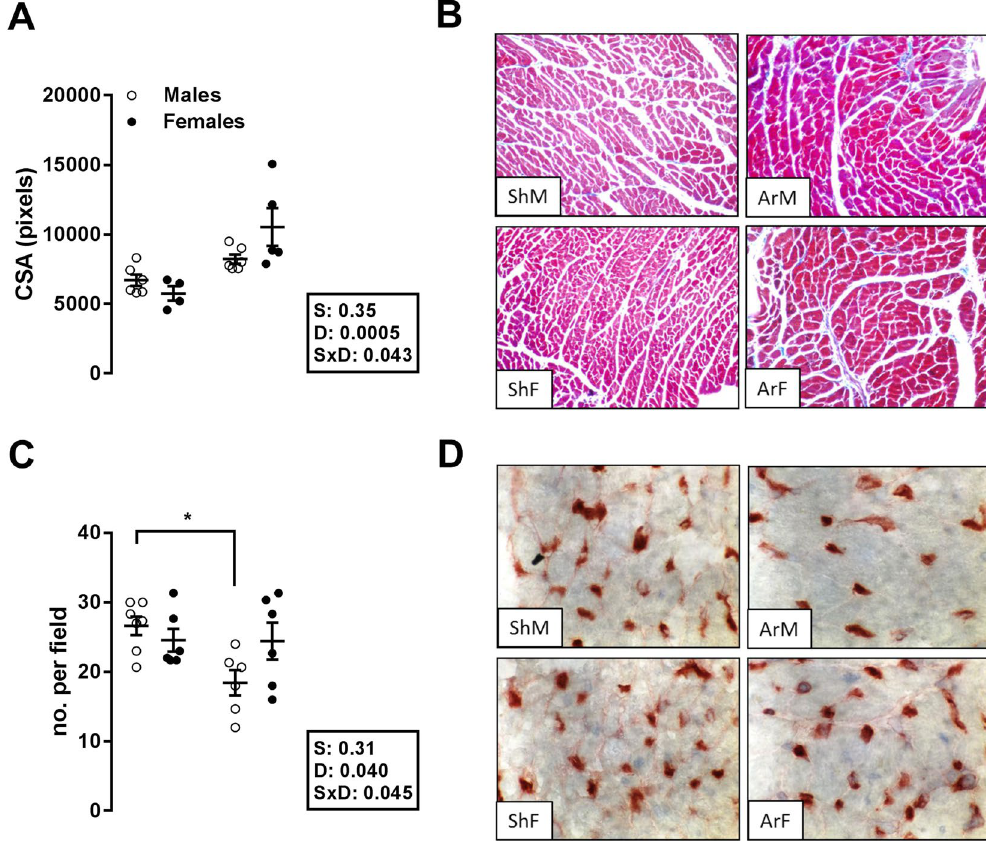
Figure 2. Impact of LV dilatation and hypertrophy caused by severe aortic regurgitation on cardiomyocyte cross-sectional area (Top panels; A and B) and on myocardial capillary density (bottom panels (C and D). Left panels (A and C): The results are expressed as the mean ± SEM (n = 6–7/gr.). Probability values are from a 2-way ANOVA and Holm-Sedak post-testing. * p < 0.05 or ** p < 0.01 between indicated groups. Upper right panels: Representative Masson’s trichrome staining of mid-chamber short-axis LV sections (magnification x200); bottom right panels: LV sections stained with isolectin B4 coupled with horseradish peroxidase (magnification